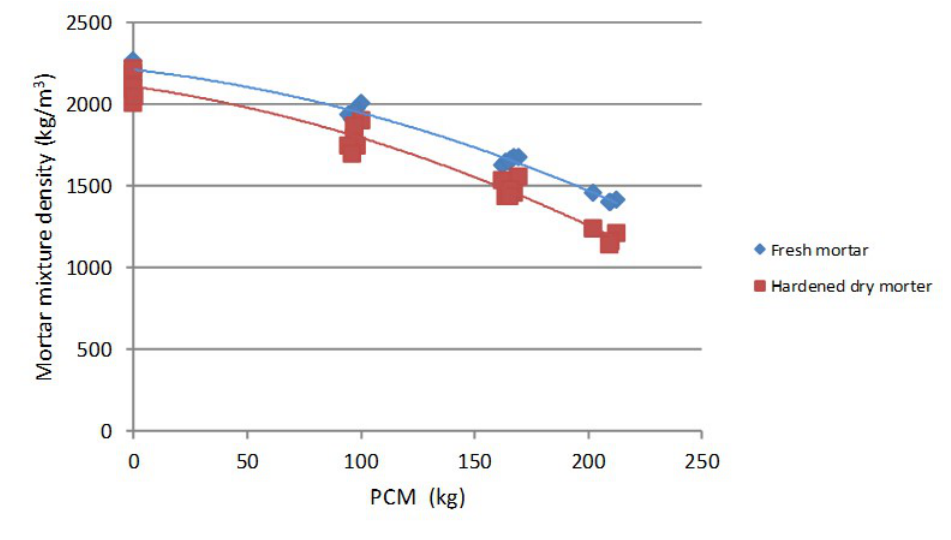
Figure 17. Density comparison of PX27 fresh and hardened mortars mixtures.